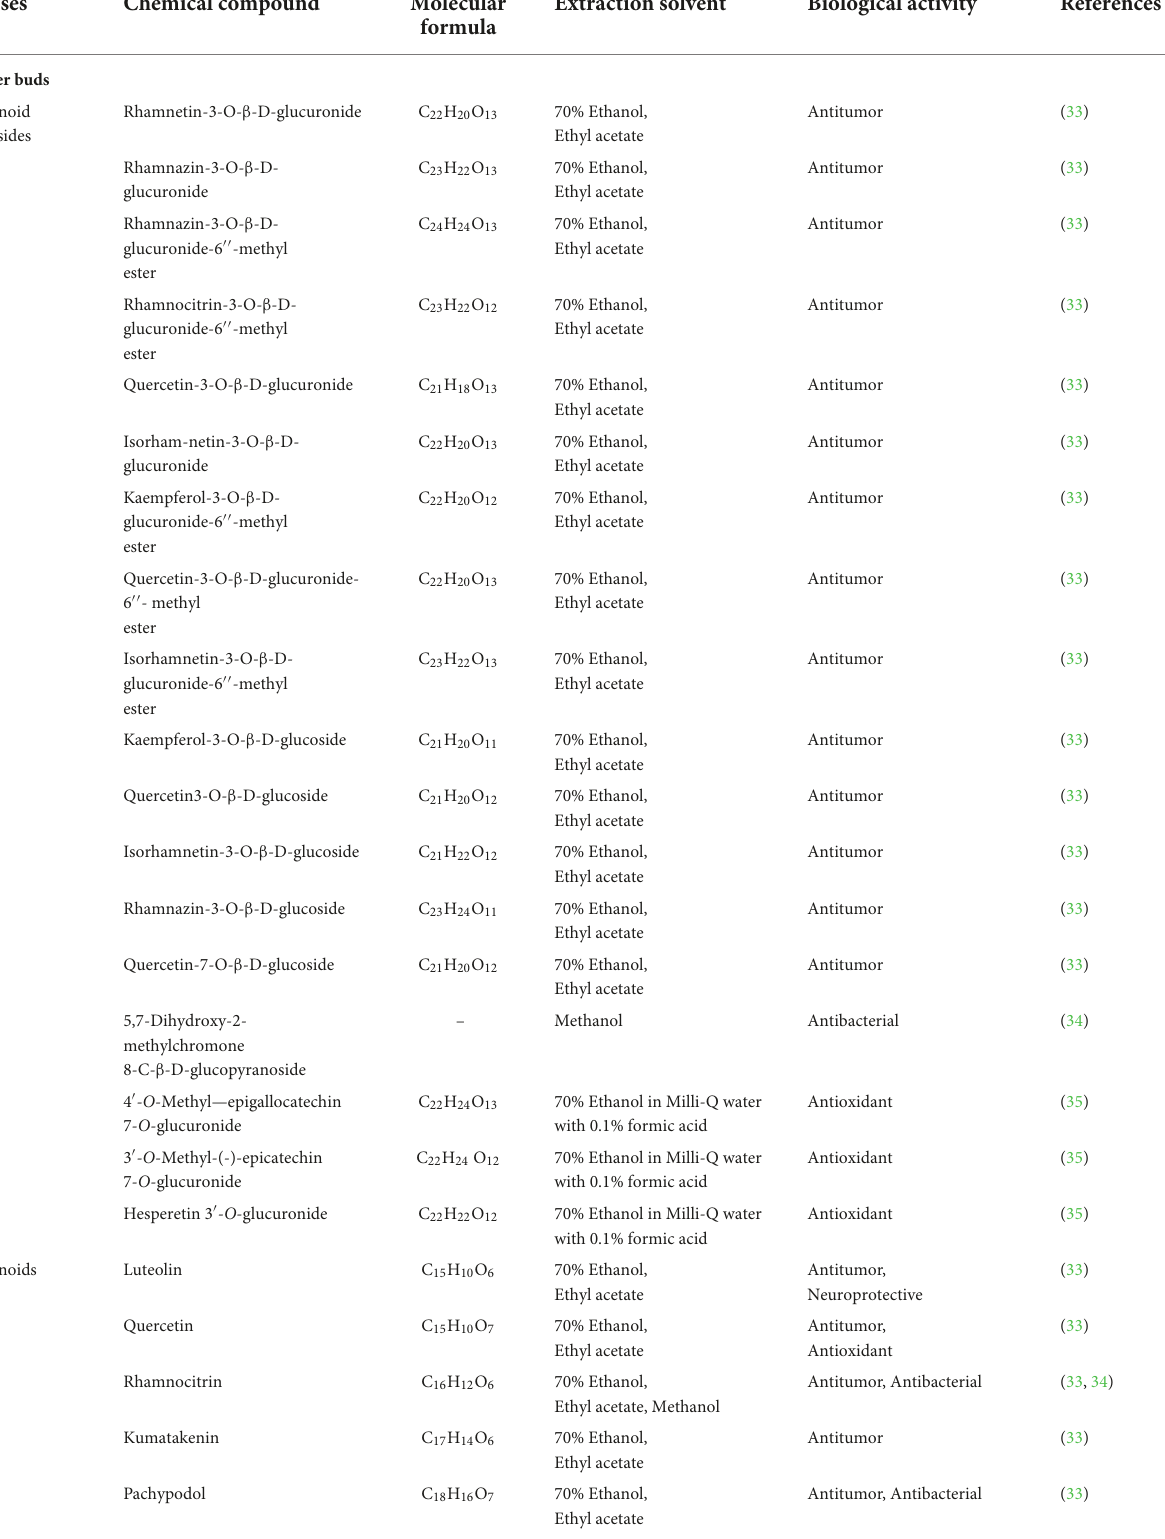
TABLE 6 Composition of non-volatile components of different parts of S. aromaticum